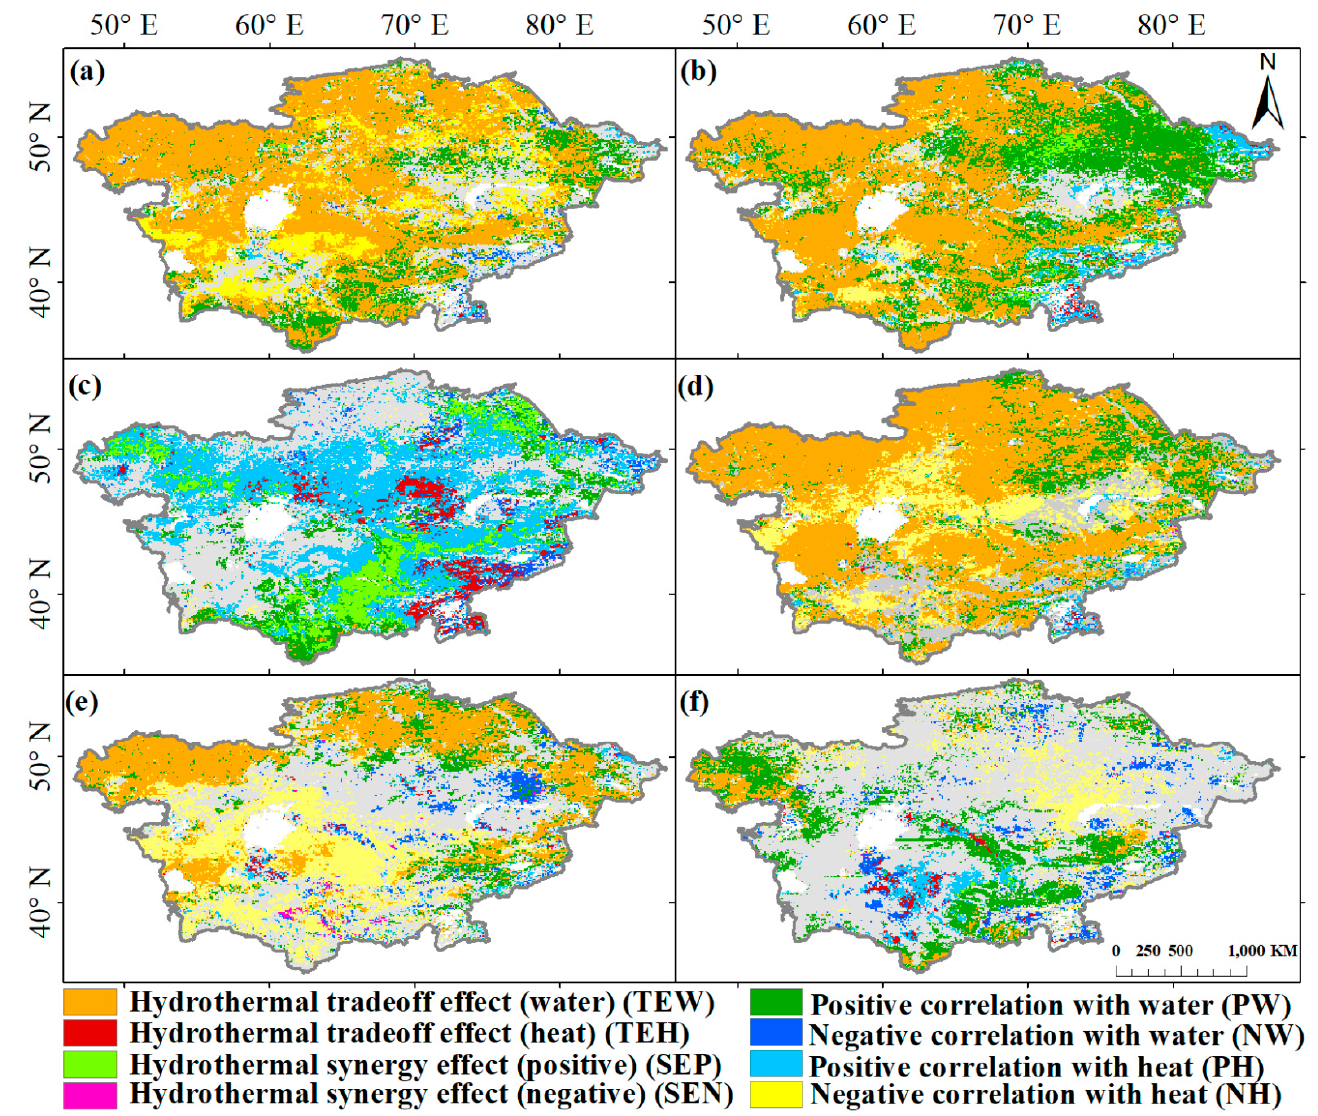
Figure 5. Spatial distributions of different function types for hydrothermal conditions affecting vegetation variations at the annual ( a ) and growing season ( b ) scales, and in spring ( c ), summer ( d ), autumn ( e ), and winter ( f ).